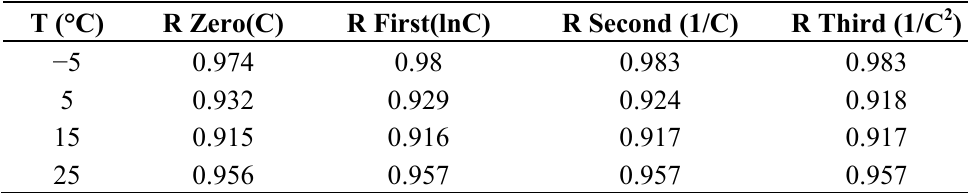
Table 1. Correlation coefficients (R) of C, lnC, 1/C, 1/C2 of caffeic acid and time at − 5, 5, 15, 25 °C under ultrasound treatment.